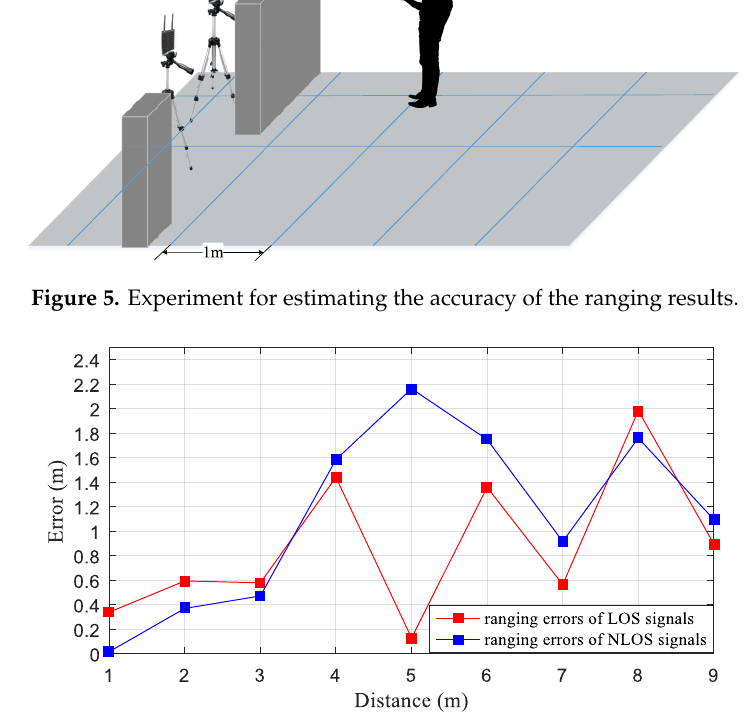
Figure 6. Ranging errors of the LOS/NLOS signals.